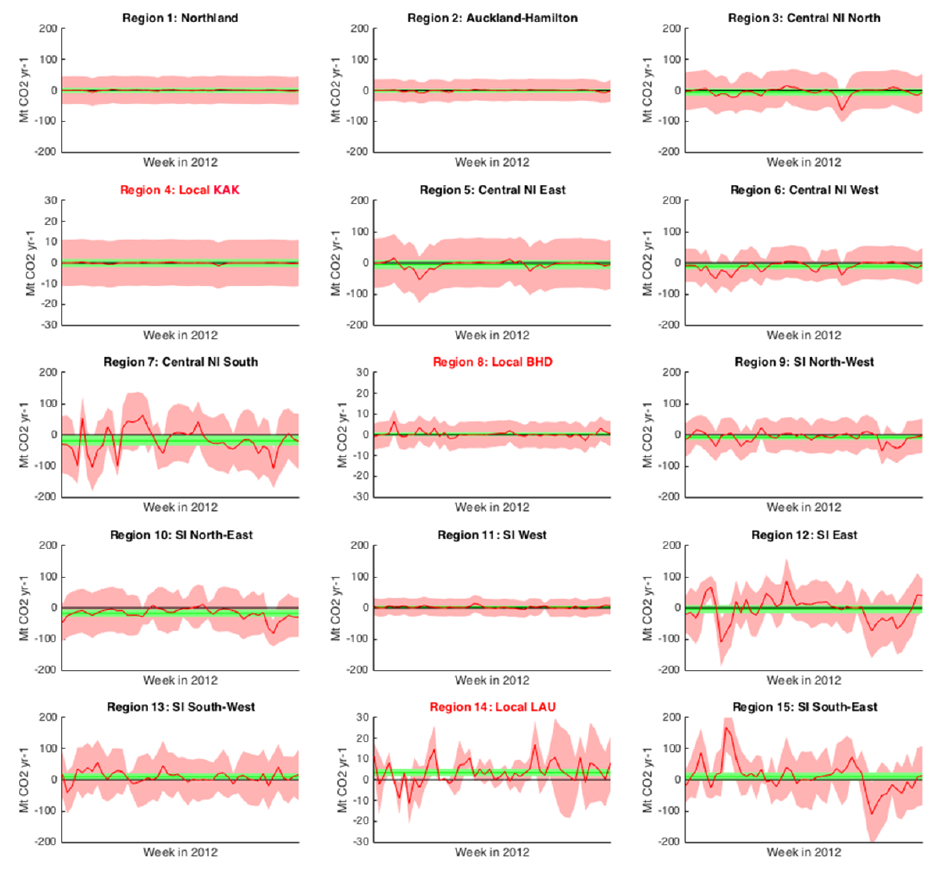
Figure 14. Deviation of the posterior flux from the “true” flux (red lines) in the synthetic data experiment with a diurnal flux cycle for the 15 land regions in 2012. Patched areas give the posterior uncertainty (excluding sensitivity cases). Green bands represent the annual mean deviation, with their thickness corresponding to the annual uncertainty. Note there is a change in scale of the flux axis for the three local regions (red